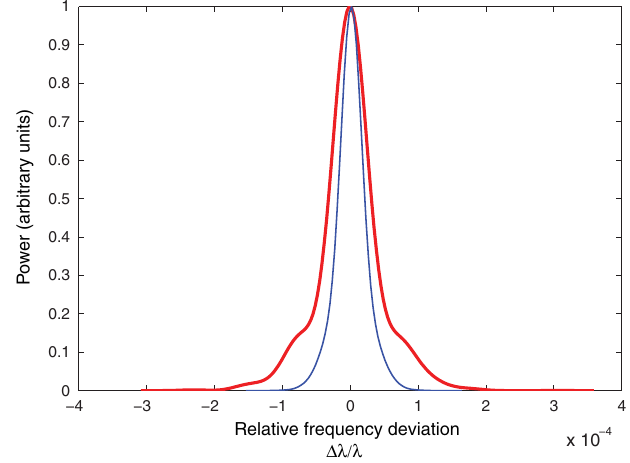
FIG. 5. (Color) Spectrum at saturation for the self-seeding (blue line) and HGHG (red thick line) schemes. FWHM bandwidths are respectively 4 : 2 (cid:2) 10 (cid:1) 5 and 6 : 8 (cid:2) 10 (cid:1) 5